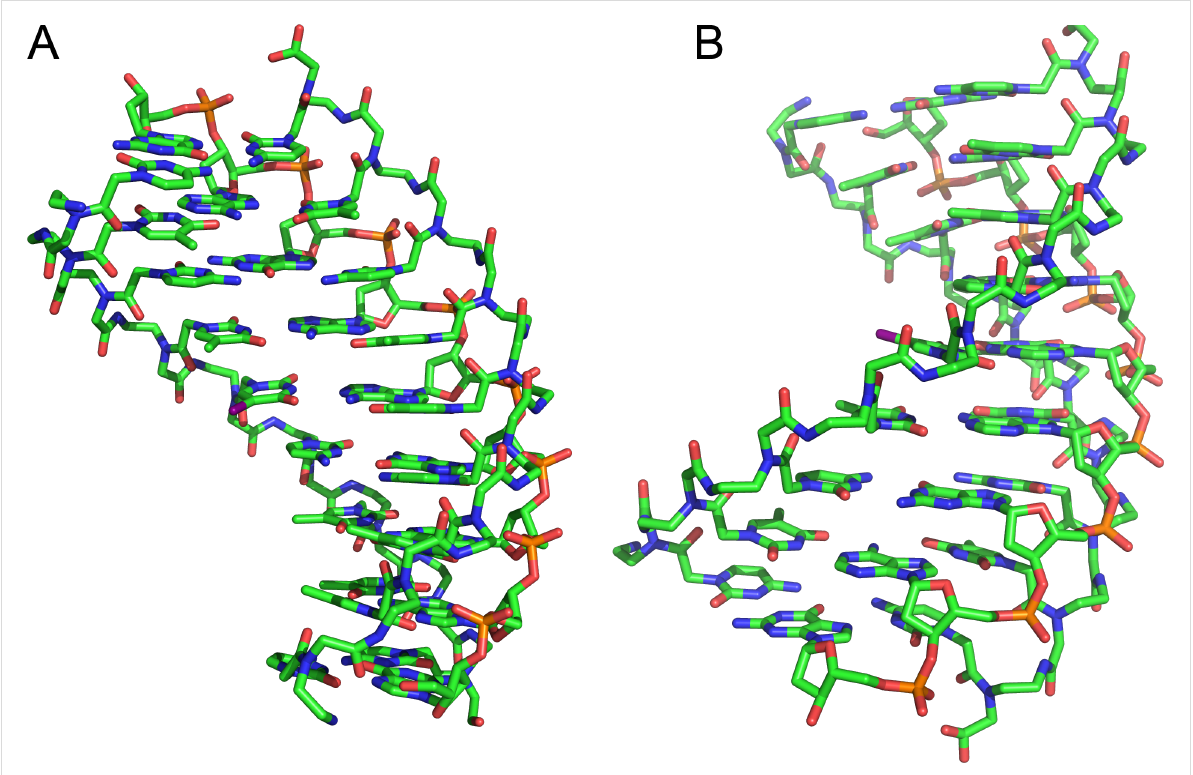
Figure 3: Structure of P-form PNA–DNA–PNA triplex from reference [41]. (A) view in the major groove and (B) view in the minor groove.